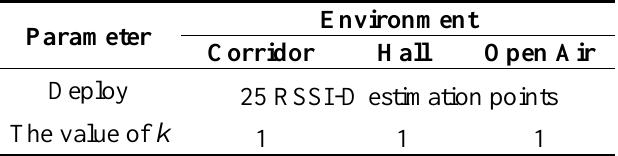
Table 2. The experimental conditions.